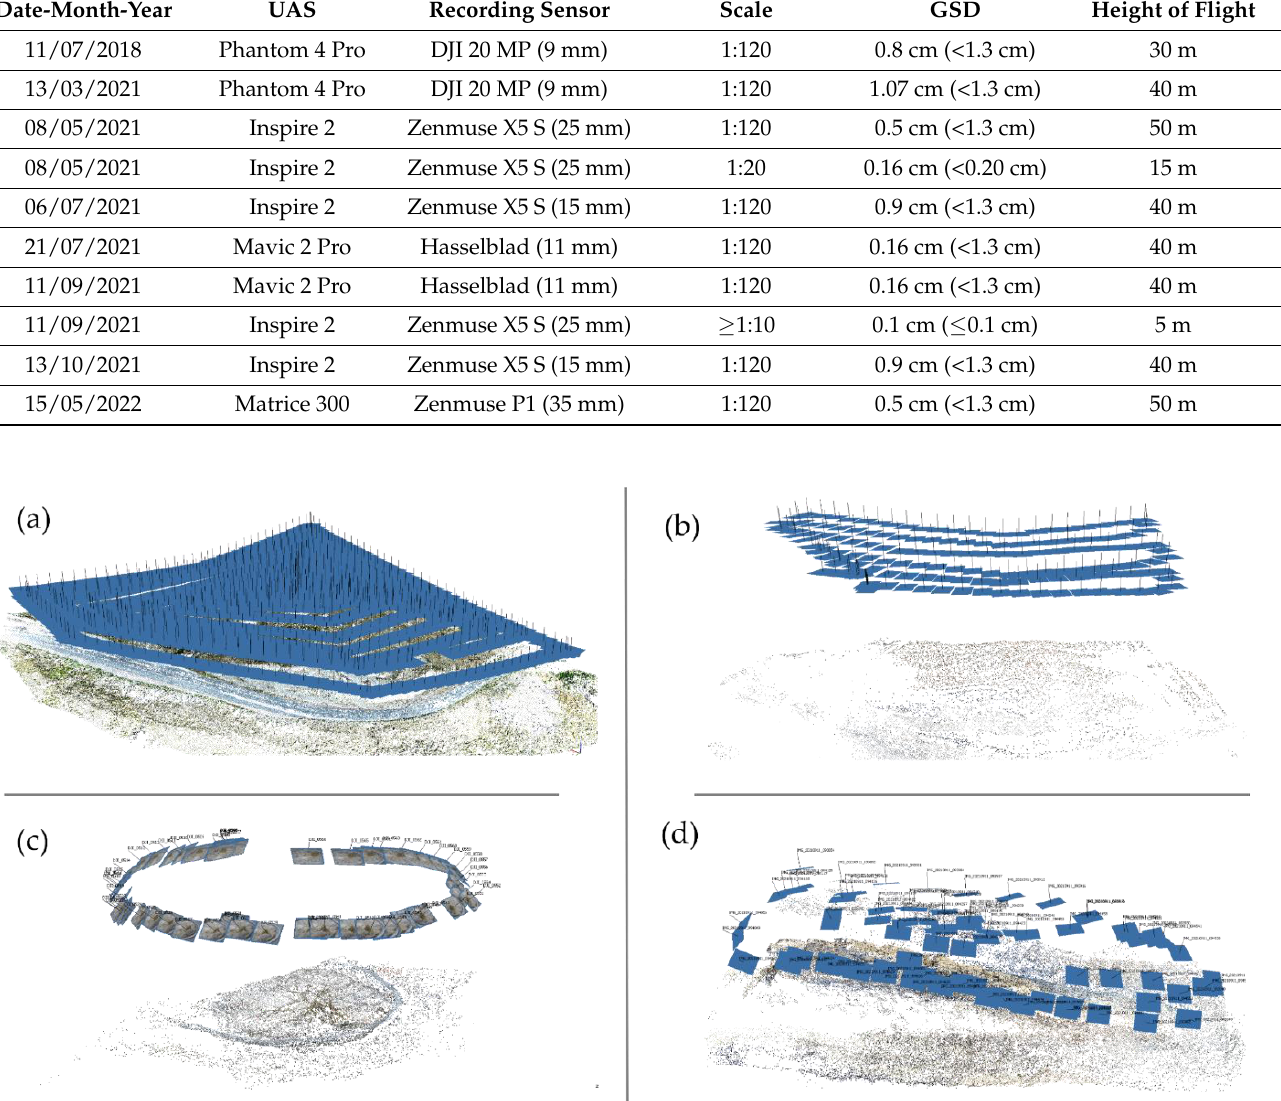
Figure 3. Flight plans for: ( a ) wider study area, ( b ) fossil-bearing site, ( c ) root system, and ( d ) single fossils. gle